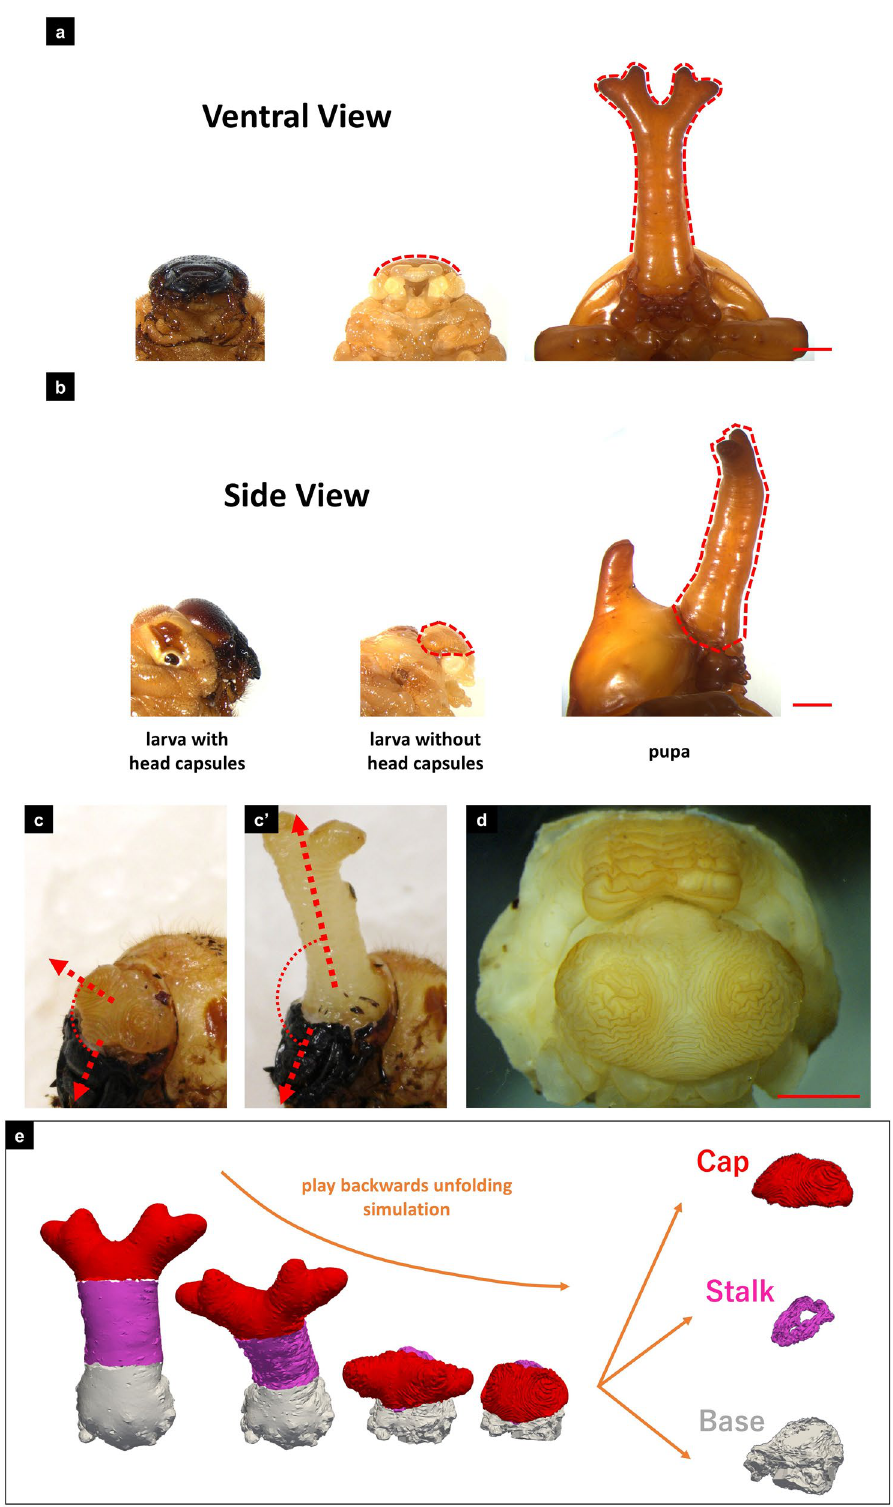
Figure 2. The transformation and division of horn primordia. ( a , b ) Comparison of larvae (left), peeled larvae (center), and pupae (right). ( a ) Ventral view. ( b ) Lateral view. Horn primordia look like domes, while pupal horns have a four-branched shape (red broken lines). The proximodistal size of a pupal horn was 6 times as big as that of a horn primordium, while the dorsoventral size changed little (areas surrounded by red broken lines). The scale bars are 5 mm. ( c , c ′ ) Forced expansion treatment 7 . In this treatment, we pushed the larval abdomen to expand horn primordia after removing the larval head capsules to observe only the transformation of horn primordia. The orientation of pupal horns was dorsally declined compared to that of primordia, as the mandibles were used as a standard (details on the definition of the orientation are given in the supplementary material). ( d ) Horn primordia. Complex furrow patterns were seen on the primordia. The scale bar is 3 mm. ( e ) The unfolded horn primordia were divided into 3 regions based on the cylindrical structure of the middle part. We named these parts cap (red), stalk (pink), and base (white), respectively. The correspondence analysis identified the areas in the folded horn primordia corresponding to each